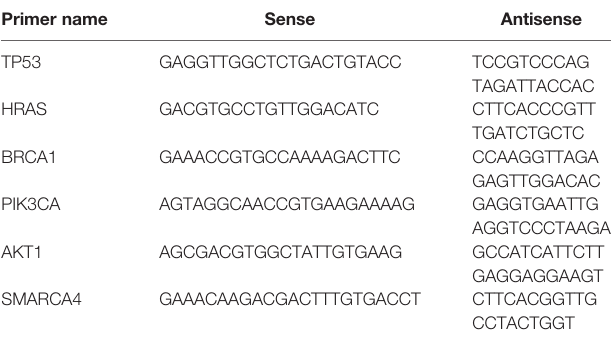
TABLE 1 | The primer of hub